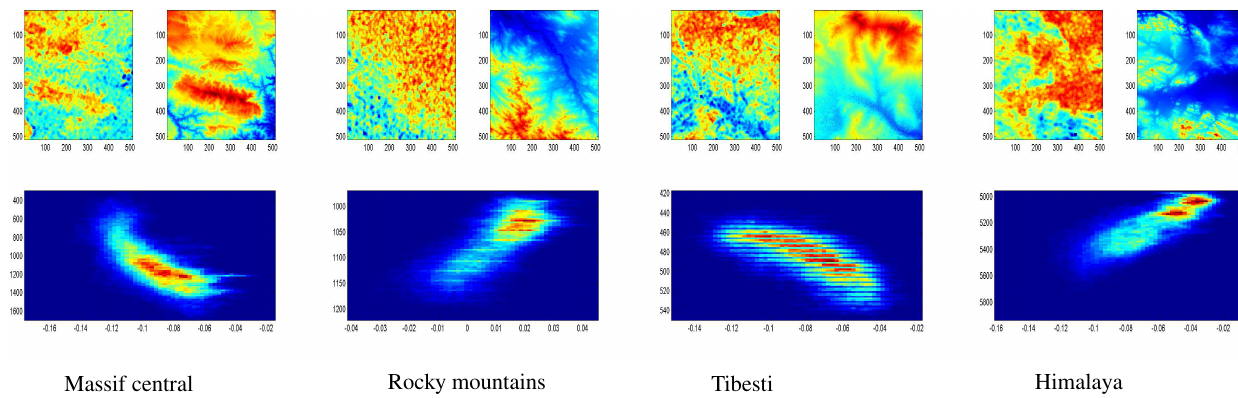
Fig. 9. In each cell, the upper-right figure is the original sub-image of length 512 pixels, the upper-left figure displays the exponent at each point of the sub-image, and the lower figure shows the density of the scatter plot in the phase plane.